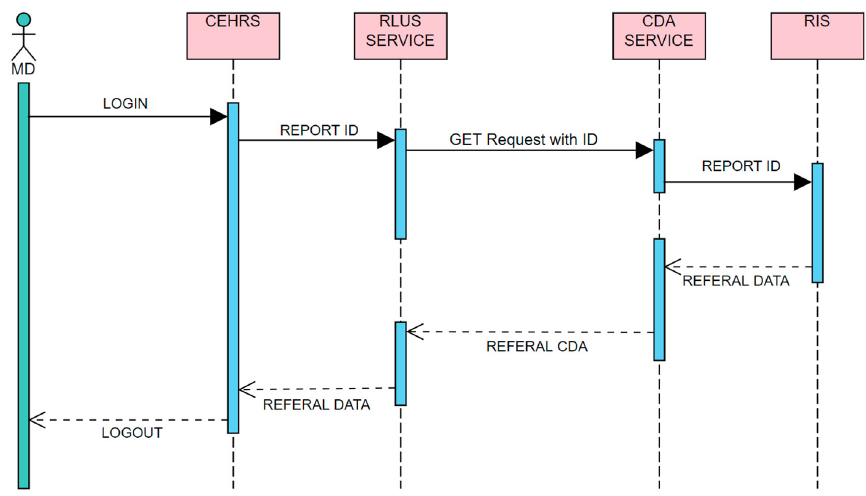
Figure 9. Pathway for the retrieval of a diagnostic report.